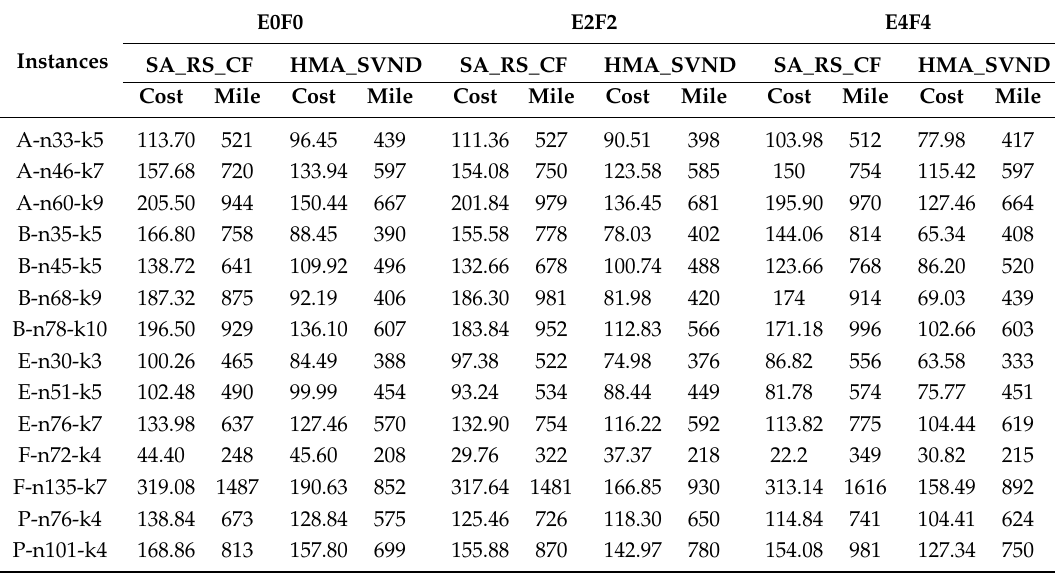
Table 3. Comparison results of HMA_SVND (proposed) and SA_RS_CF